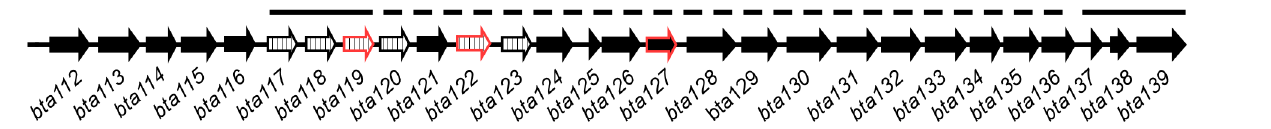
Fig 2. Assembly of ORFs ( bta117 to bta139 ), shown as arrows, toward the 3 ’ end of lp150. Paralogues are represented with a vertical lines (b ta117 to bta120 , bta122 , and bta123 ) or red outline ( bta119 , bta122 , and bta127 ). Solid horizontal lines are above ORFs ( bta117 to bta119 ) that spanned the gap between the partially assembled plasmid and 28.1 kb contig (dotted line), and those that were assembled at the end of the plasmid ( bta137 to bta139 ).